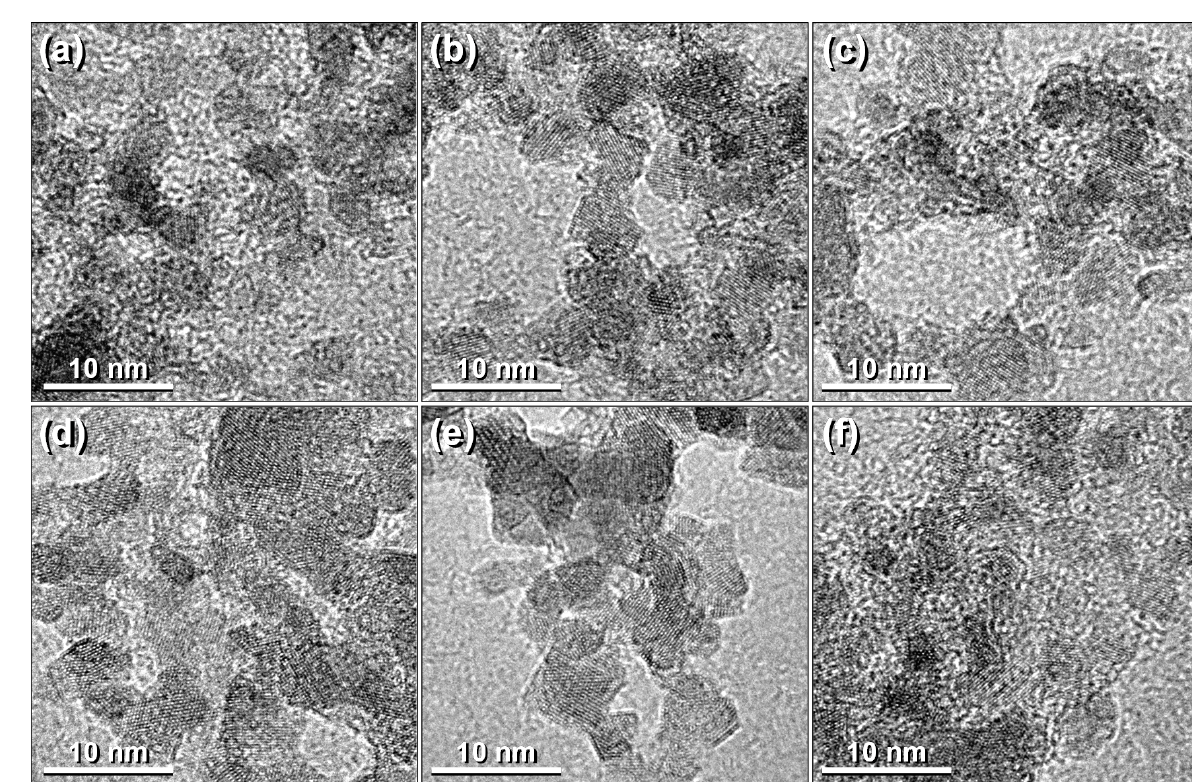
Figure 6. TEM images of the samples: ( a ) NP0, ( b ) NP1, ( c ) NP2, ( d ) NP3, ( e ) NP4, and ( f ) NP5.